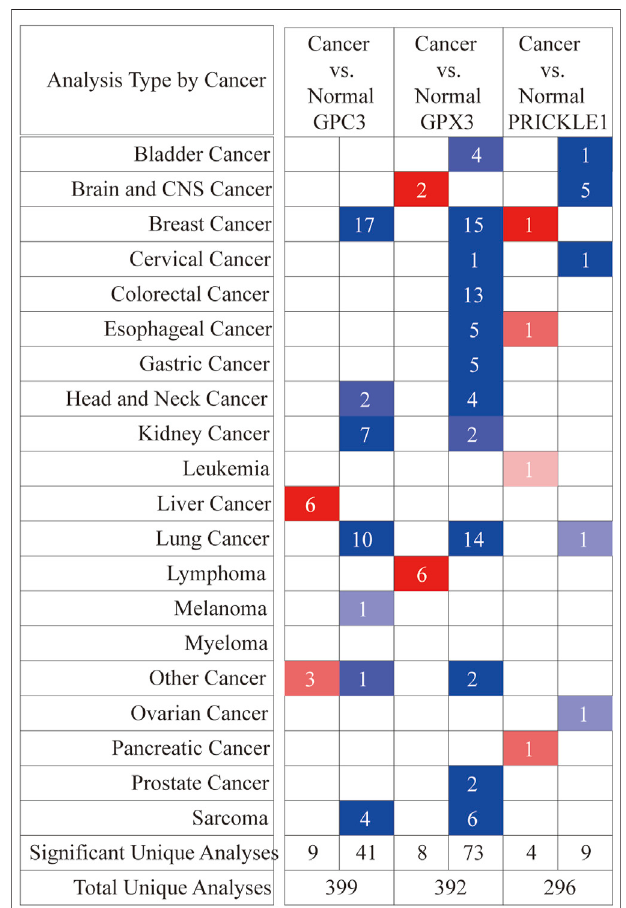
FIGURE 6 | Differential expression of three signature genes in cancer andadjacenttissuein20tumorsattheONCOMINEdatabase.Student ’ sttest was used to compare the differences in mRNA expression. Red represented overexpression and blue represented low expression. The darker the color, the more obvious the difference in gene